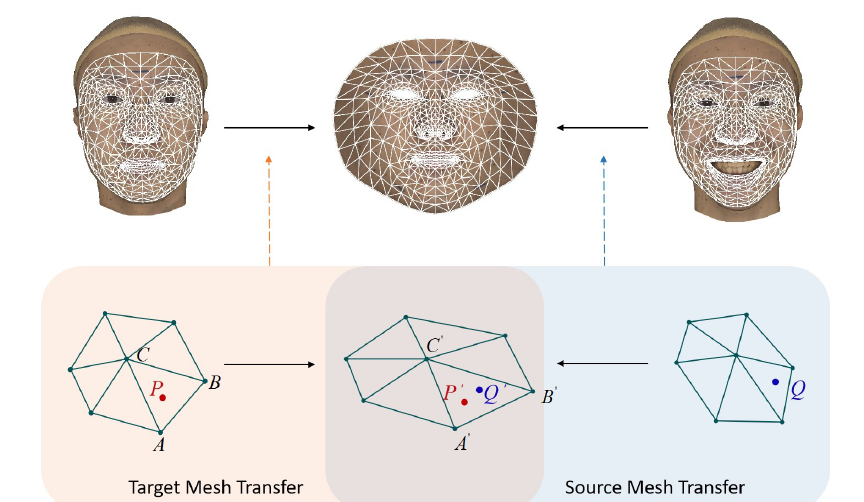
Figure 3. Transfer of marker and mesh.